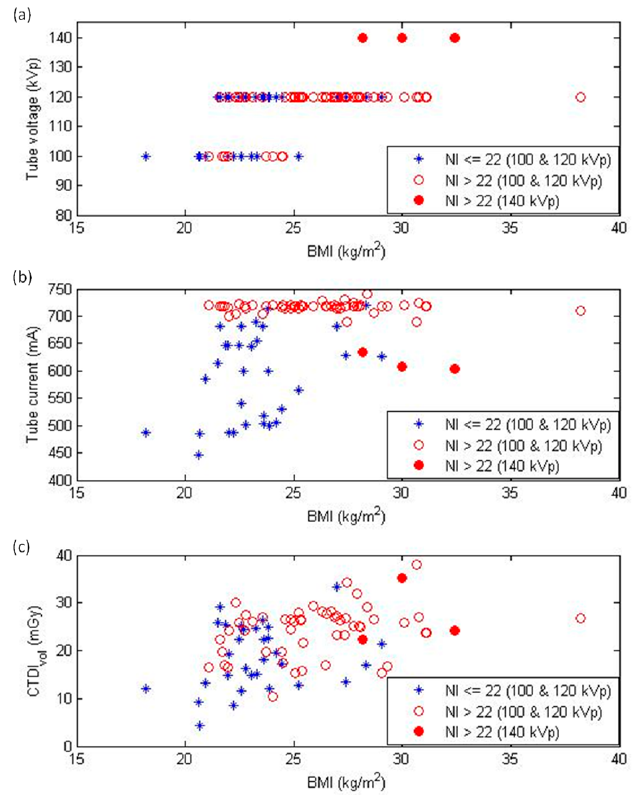
Figure 3. Distribution of ( a ) tube voltage, ( b ) tube current, and ( c ) volume CT dose index (CTDI vol ) as functions of body mass index (BMI). NI = noise index. Table 3. Comparison of NI, subjective image quality score, and objective noise measurements in different BMI